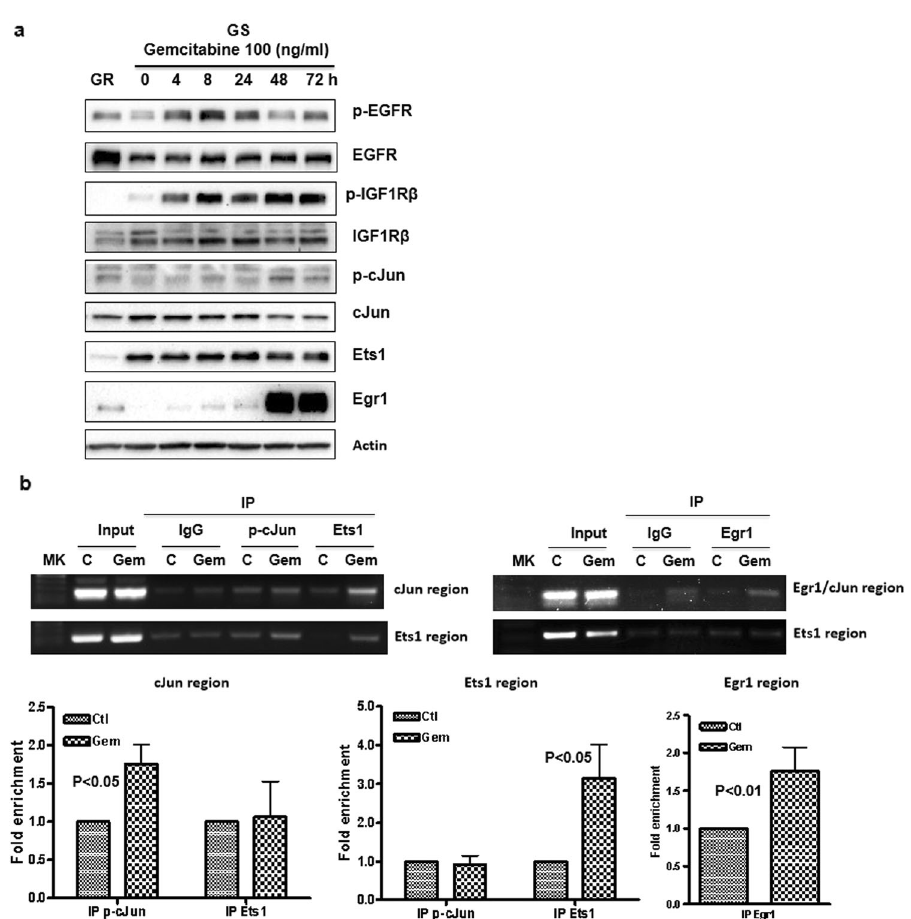
Fig. 4 Gemcitabine treatment induces IGF1 signaling and binding of transcription factors p-cJun, Ets1, and Egr1 to CD44 promoter. a GS cells were treated with gemcitabine for the indicated period. EGFR, IGFR phosphorylation, and transcription factor p-cJun, Ets1, and Egr1 were detected by Western blot analysis. b GS cells were treated with gemcitabine for 48 h and chromatin immunoprecipitation assays were performed. The binding of p-cJun, Ets1, and Egr1 to CD44 promoter was analyzed by regular PCR (upper panel) and by quantitative PCR (lower panel). Fold enrichments are represented as signals obtained from immunoprecipitation with speci fi c antibodies relative to signals obtained from immunoprecipitation with control IgG (mean ± SD from triplicate). survival 28 months) tended to have a slightly better prognosis than analyzed using the TCGA pancreatic cancer dataset. There were the CD44-high/IGF1R-high group although the difference was not 178 patients with both CD44 and IGF1R expression, from which, statistically signi fi cant (Fig. 7a). These results are consistent with our the RNA expression data were divided into four groups: CD44- current in vitro fi nding that the CD44-high phenotype is more high/IGF1R-high, CD44-high/IGF1R-low, CD44-low/IGF1R-high, and tumorigenic and may require IGF1R signaling for initiation but not CD44-low/IGF1R-low groups. These groups were compared for for the maintenance of this phenotype. CD44-low groups either overall survival rate and 138 patients ’ available data for IGF1R-high ( n = 35, mean survival: 39 months) or IGF1R-low ( n = 62, determining progression-free survival rate. mean survival: 38 months) showed the longest overall survival The worst overall survival was seen in patients whose tumor was (Fig. 7a). The worst progression-free survival was seen in the CD44- CD44-high/IGF1R-high ( n = 42, mean survival 22.8 months) (Fig. 7a). high/IGF1R-high group ( n = 33, mean progression-free survival: Patients whose tumors were CD44-high/IGF1R-low ( n = 39, mean Cell Death and Disease (2022)